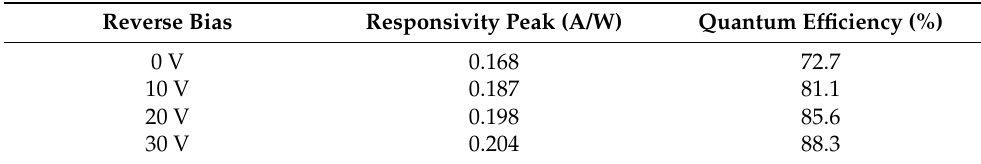
Table 2. Responsivity and quantum efficiency for different bias condition at a 285-nanometer wavelength.